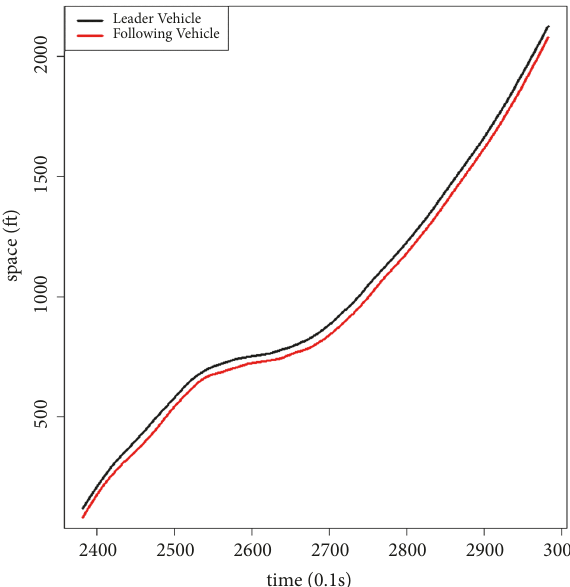
Figure 2: The example case for the analysis.